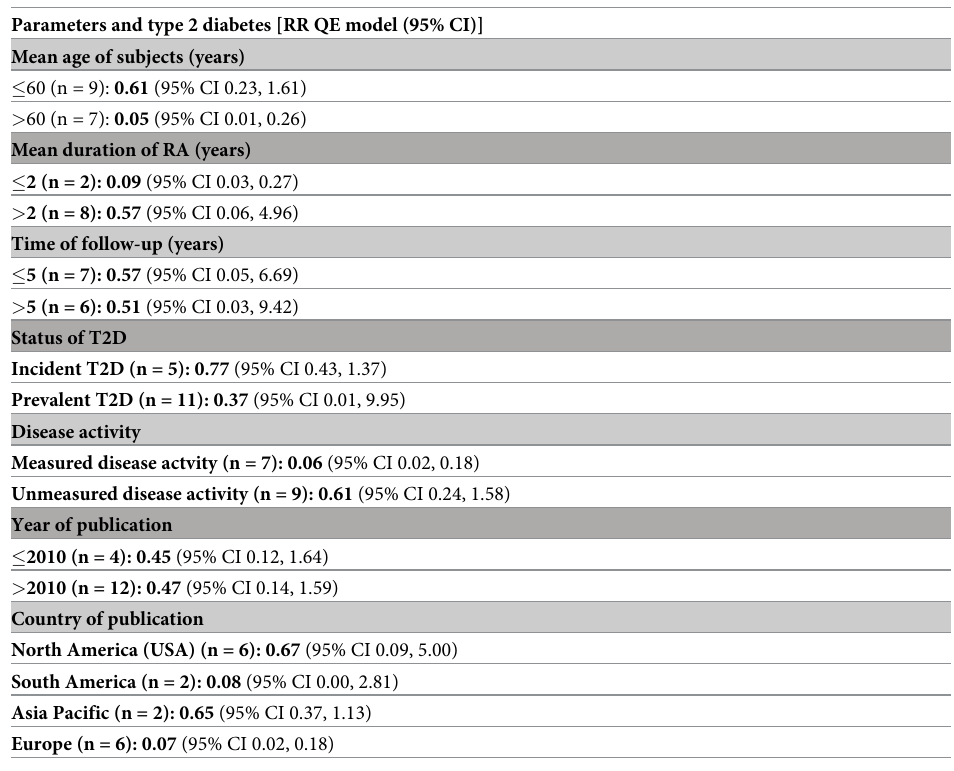
Table 2. Sensitivity analyses of methotrexate and type 2 diabetes in RA